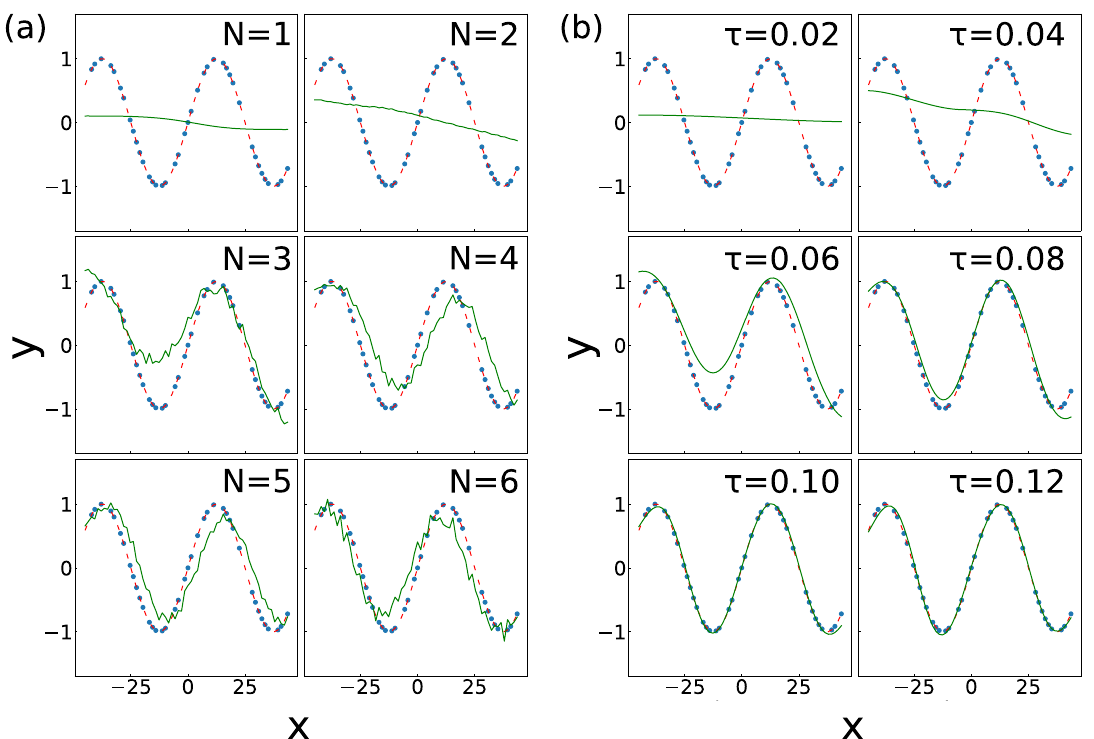
Fig. 2 Demonstration of one-dimensional regression task of y ¼ sin ð 2 π x = 50 Þ . a , b shows results for NMR kernel and numerically simulated kernel, respectively. The blue dots, green lines, red dashed lines represent the training data, the prediction of the trained model, and the function from which the function the training data are sampled.